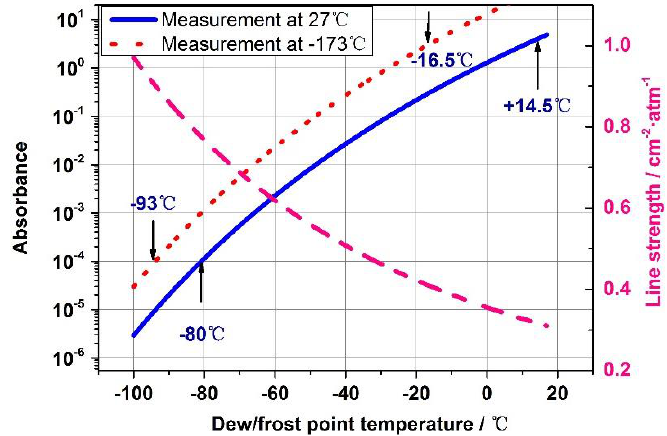
Figure 7. Simulation of the water vapor 7242.37cm −1 and 7243.08cm −1 peak absorption in air under different dew/frost point temperature conditions and a pressure of 1 atm. The red dotted line is the result of a gas temperature of −173 °C. In this case, the water vapor would be supersaturated. The blue solid line is the result of a gas temperature equals 27 °C. The line strength at different temperature (pink dash line) are based on the spectroscopic database HITRAN. (Note: the horizontal axis label for the line strength curve should simply read temperature not dew/frost point.).